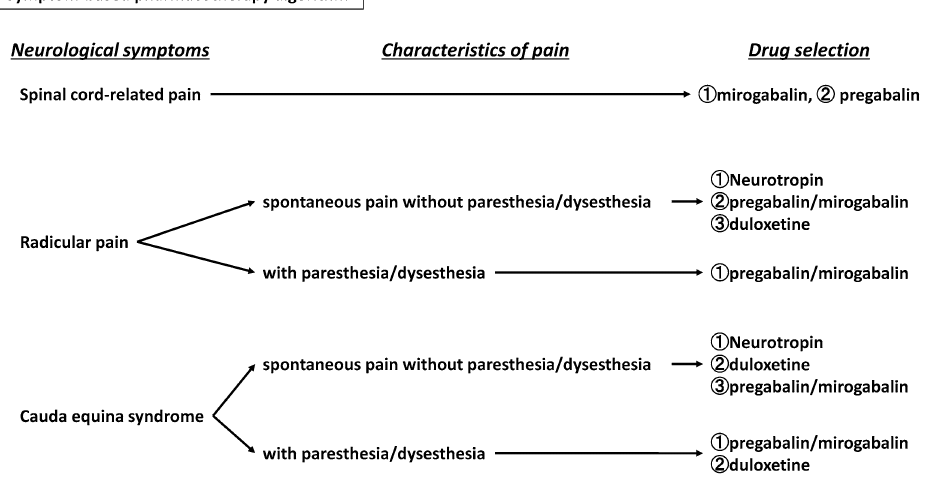
Figure 2. Symptom-based pharmacotherapy for patients with neuropathic pain related to spinal disorders. The drug should be chosen, based on the neurological symptoms and characteristics of the